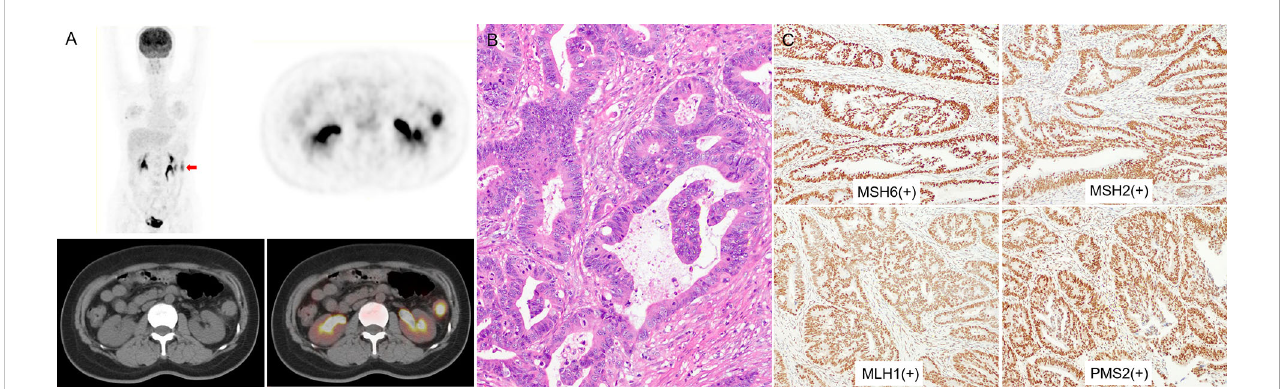
FIGURE 4 (A) a 48-year-old woman with left colon cancer. 18 F-FDG PET/CT showed hypermetabolism in the descending colon (arrow; SUV max 9.86; HI 60% 1.38). (B) The pathological diagnosis was moderately differentiated CRC, without mucinous component. (C) IHC analysis results for MMR proteins were MSH6 (+), MSH2(+), MLH1(+), and PMS2(+), indicating